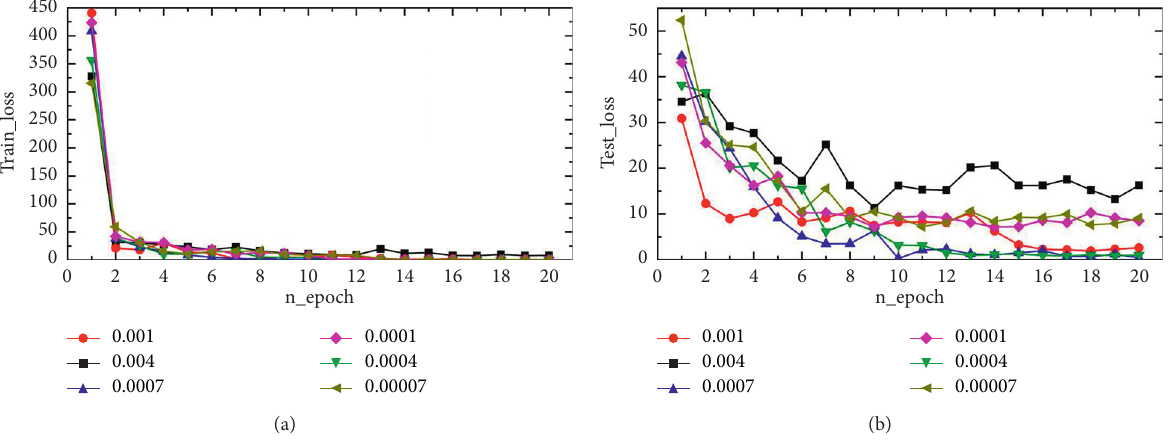
Figure 4: Loss curve under different learning rates.